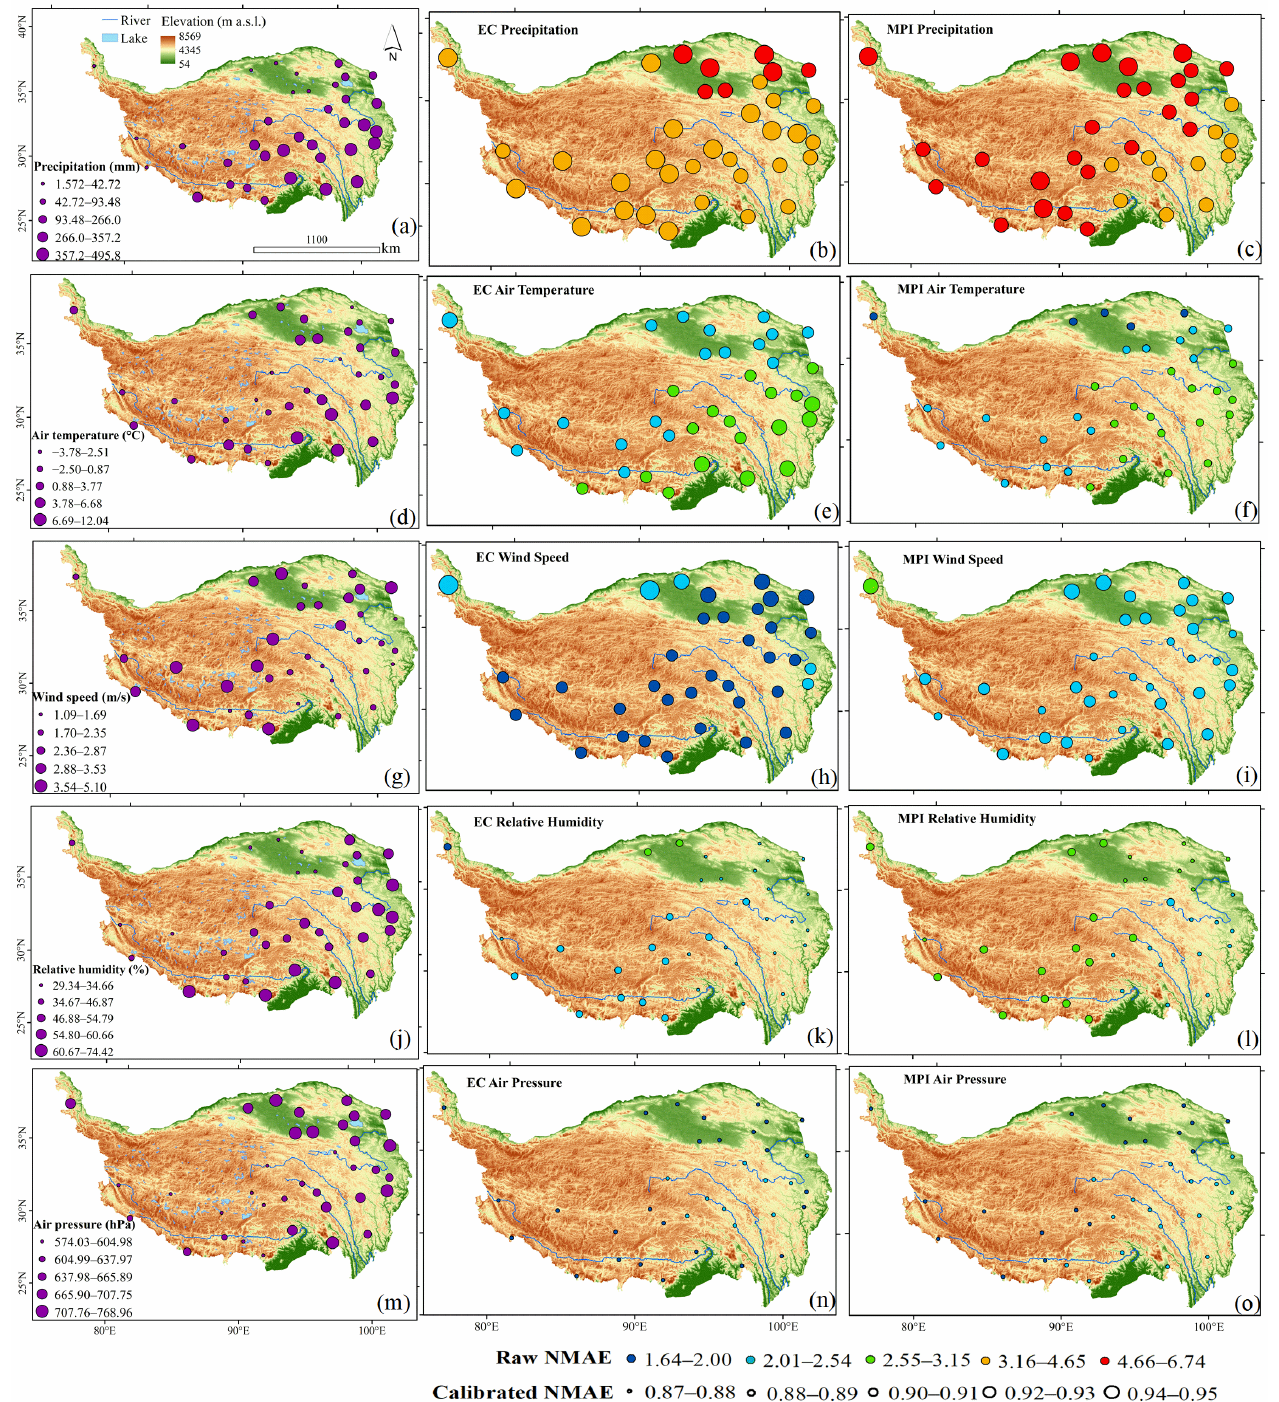
Figure 5. Spatial distributions of the NMAE values of the calibrated results and the raw GCM simulations of atmospheric variables at the 36 selected QTP sites from two GCM data (middle: ( b , e , h , k , n ) for EC; right: ( c , f , i , l , o ) for MPI) for the first adjustment (results corresponding to 1985–1999), together with the 15-year means of the variables observed in the same period (left: ( a,d,g,j,m )). Rows from the upper down represent precipitation ( a – c ), air temperature ( d – f ), wind speed ( g – i ), relative humidity ( j – l ) and air pressure ( m – o ), respectively. The NMAE values are broken into 5 classes. In the middle and right panels, the color of the circle represents the class of NMAE value of the raw GCM simulations (blue to red for low to high NMAE; annotated as Raw NMAE) and the size of the circle represents the magnitude of NMAE value of the calibrated results (small to large circles for low to high NMAE; annotated as Calibrated NMAE). N = 180 for each